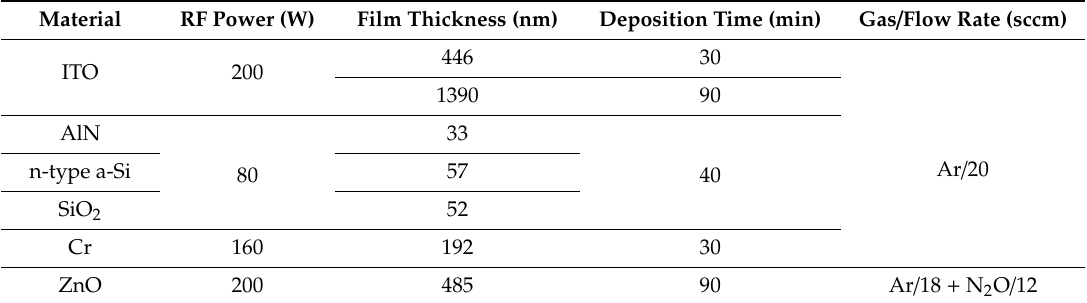
Table 1. Target materials and radio frequency (RF) sputtering conditions used to deposit thin films.